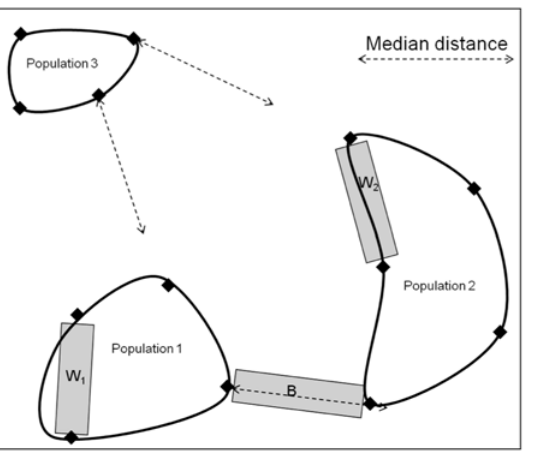
Fig 2. Diagram of point selection for habitat segments between and within genetically identified populations. The dashed line indicates the median distance between sample points within a population, averaged across all 70 populations in the study. In this example, the minimum distance between sample points from populations 1 and 2 is less than the median distance and qualified for analysis. However, the minimum distance between sample points from population 3 and the others exceed the median distance, so these did not qualify for a “ B ” segment. The shaded rectangle represents the segments, B = between populations and W = within